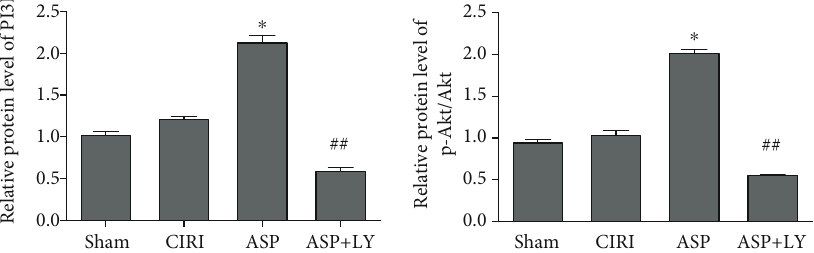
Figure 6: ASP activated PI3K/AKT signaling pathways. PI3K, AKT, and p-AKT protein levels in CIRI rats measured by western blot analysis. Note: compared with the CIRI group, ∗ P < 0 : 05 ; compared with the ASP group, ## P < 0 : 01 . N = 10 per